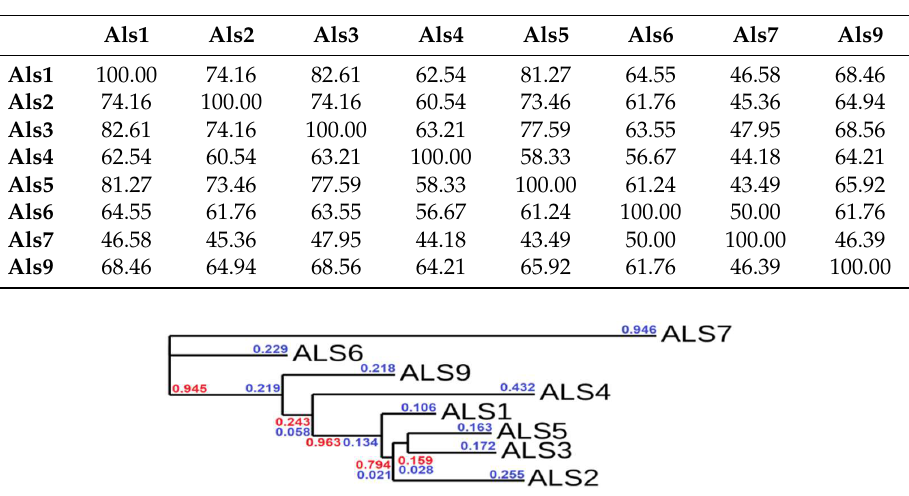
Figure 6. Sequence alignment for the Als targets. Table 7. The similarity matrix of the primary structures of different Als.